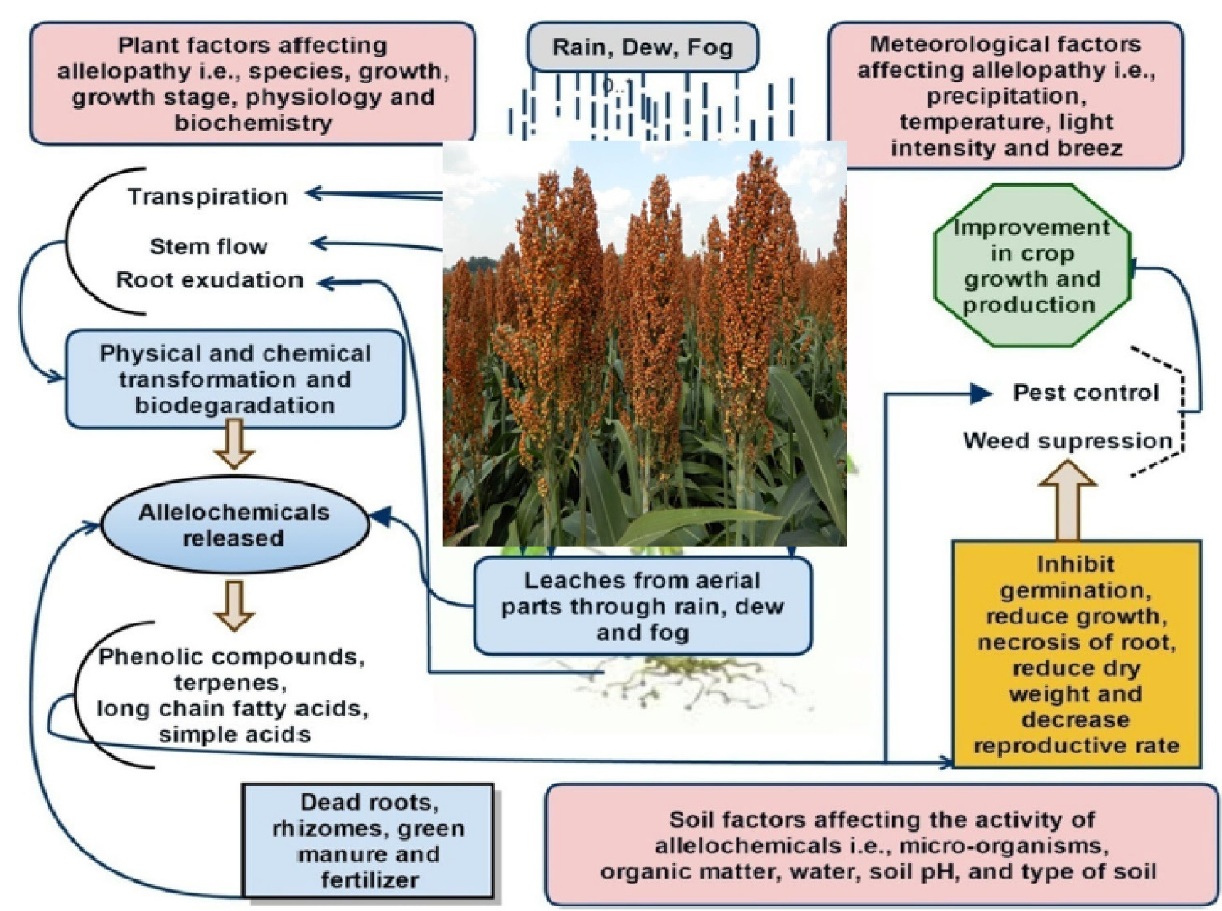
Figure 2. Overall processes of sorghum allelopathy in the soil environment and factors affecting allelopathy. The figure describes the way of allelochemical production from the plant parts, leachates from aerial parts, surface mulch, soil incorporation, spray of aqueous extracts, rotation, smothering, root exudates, and mix cropping.